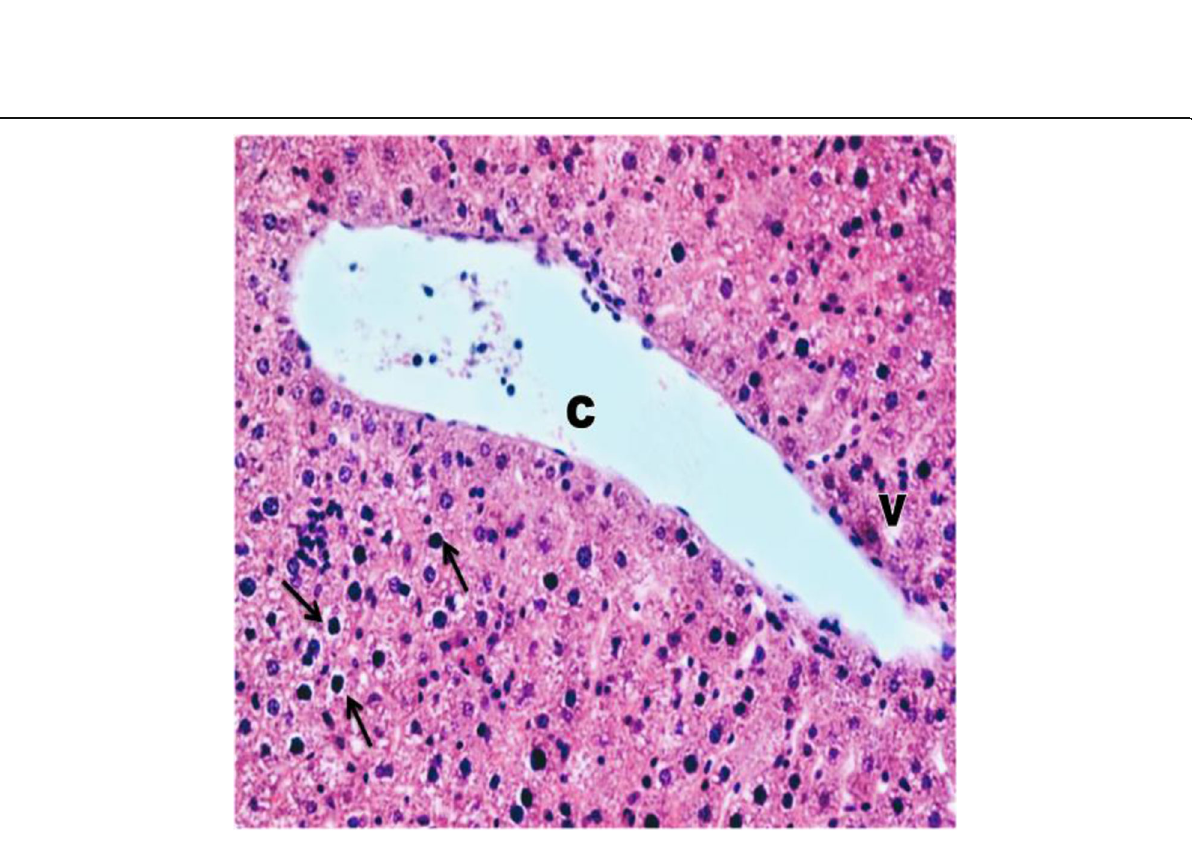
Fig. 5 Photomicrograph of a section of the liver of treated mouse with Tamiflu (16 mg/kg b.wt.) for 15 days revealing hepatocytes with vacuoles (V) and pyknotic nuclei (arrows) in addition to enlargement and distortion of central vein (C). (H&E, × 400)